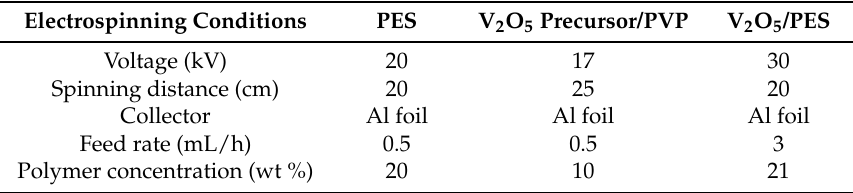
Table 5. Electrospinning conditions of the nanofibers produced in this study. Electrospinning